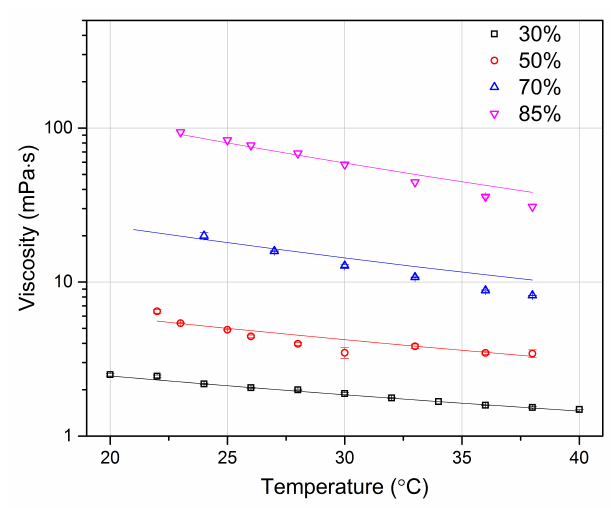
Figure 8. Viscosity of glycerol mixtures with water at different mass concentrations and different temperatures. Experimental data in scatter symbols are compared with results from literature